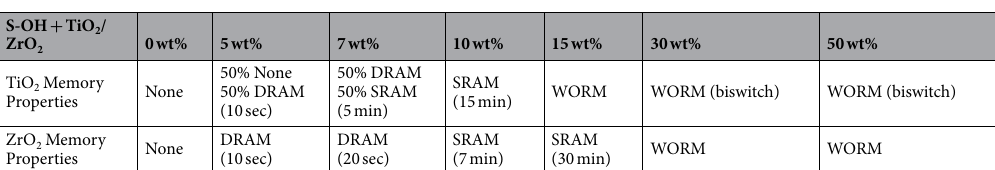
Table 3. Summary of S-OH, S-OH/TiO 2 , and S-OH/ZrO 2 memory